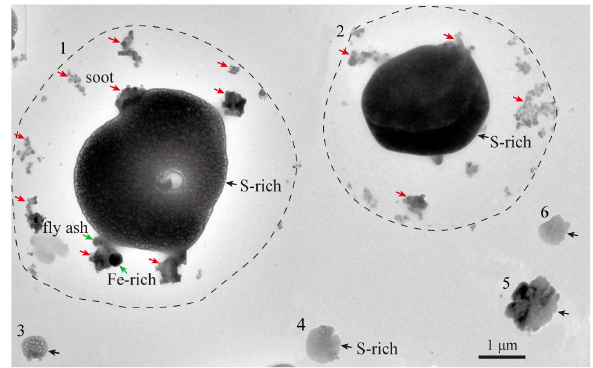
Figure 8. TEM image of cloud RES and INT particles collected during the cloud event that occurred on the polluted day of 31 July. Particles 1 and 2 are cloud RES and particles 3, 4, 5, and 6 are cloud INT. The dashed lines indicate the water rims that were left after the cloud droplets impacting the substrate